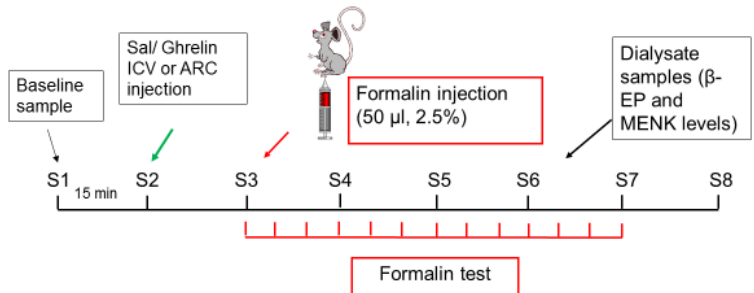
Figure 6. Schematic representation of the experimental design. The microdialysis and formalin test were performed 24 h after implantation of the microdialysis probe. Sample 1 (S1, 30 µL) was collected as the baseline value, and then Saline/Ghrelin were injected into the lateral ventricle (ICV) or arcuate nucleus (ARC) (S2). Dialysate samples were collected every 15 min for 2 h, the last sample (S8) being 15 min after the end of the formalin test. The formalin test was started after the optimal time for the outcome of the drug (15 min), and pain scores were recorded every 5 min for one hour. The formalin test was started after the optimal time for the outcome of the drug (15 min). All groups received 50 µL formalin 2.5% subcutaneously in the left hind paw. Animals were then divided